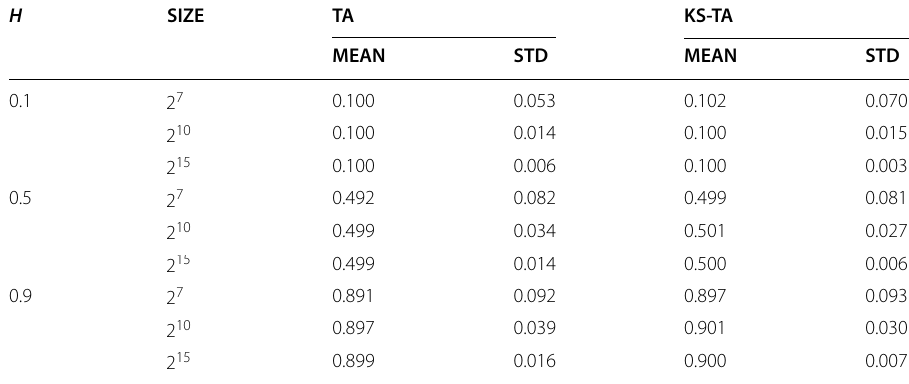
Table 2 Results of the Monte Carlo design to calculate the Hurst exponent with TA and KS‑TA for fractional Brownian motions with different H s and sizes H SIZE